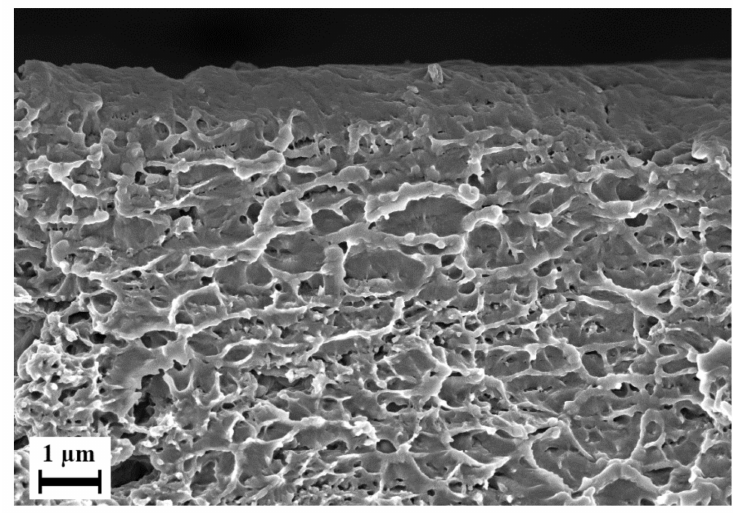
Figure 16. Porous structure observed inside the microcellular foam of the blend